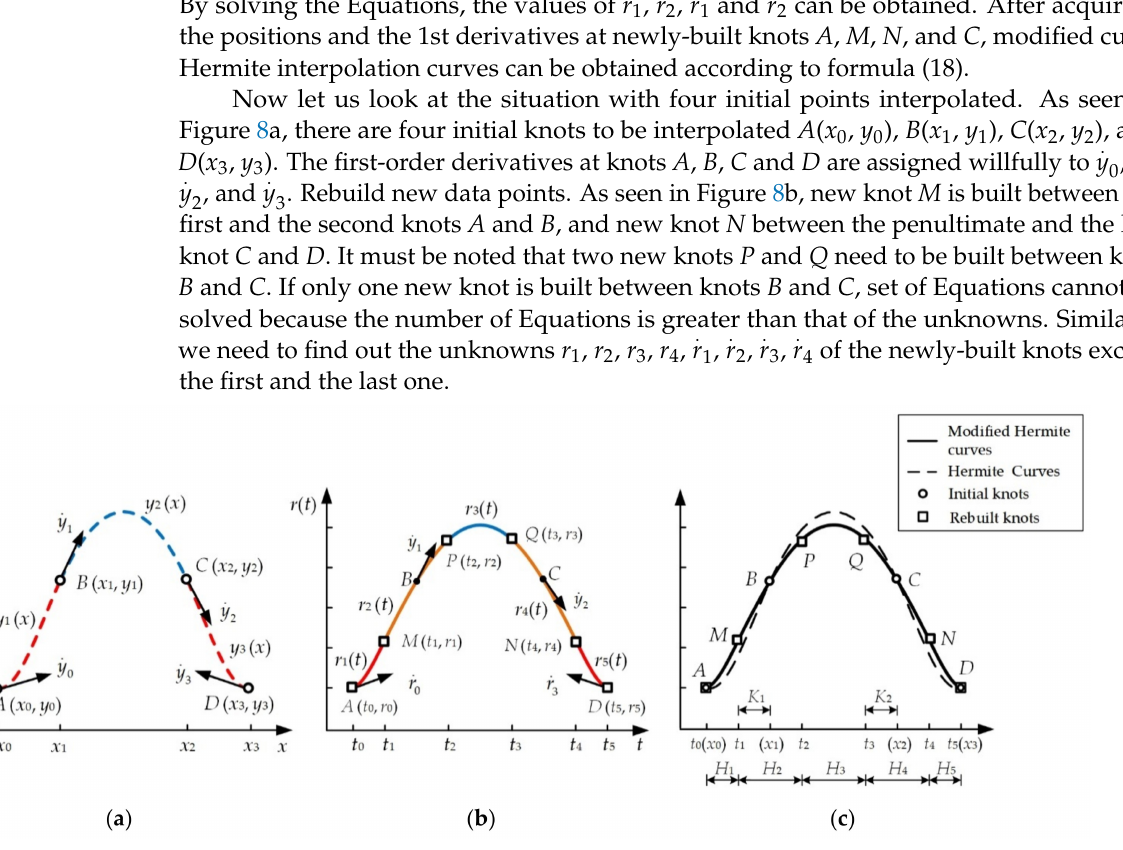
Figure 8. Piecewise cubic Hermite interpolation curves with four initial knots: ( a ) Interpolation with initial knots; ( b ) Interpolation with rebuilt knots; ( c ) Comparison between two kinds of